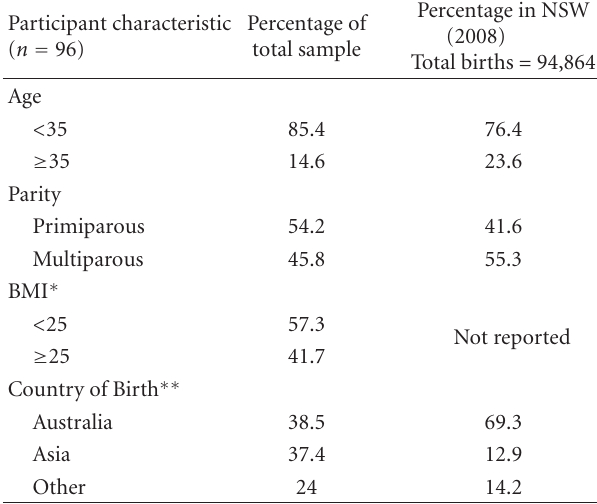
Table 1: Participant